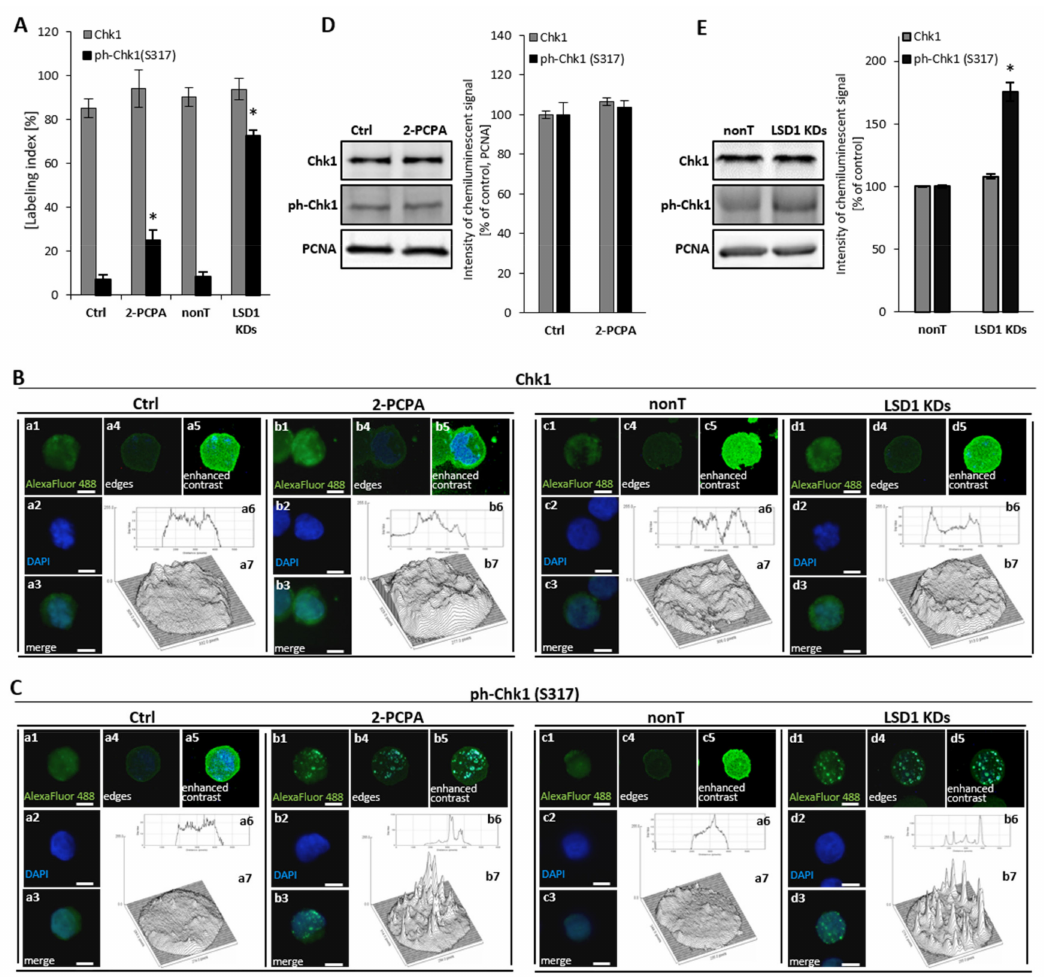
Figure 2. Consequences of LSD1 inhibition / silencing in human microvascular endothelial cells on checkpoint kinase 1 (Chk1) activation. Immunofluorescent analysis of the Chk1 level ( A , B ) and the Chk1 activation (ph-Chk1(S317) level ( A , C ). Cells were stained with anti-Chk1 or anti-ph-Chk1(S317) antibodies conjugated with AlexaFluor 488 fluorescent dye. The labeling index was calculated as the ratio of immunofluorescence-labeled cells to all cells in an HMEC-1 cell population. The intensity of fluorescence was visualized in ImageJ program ( B a6, a7, b6, b7; C a6, a7, b6, b7). The presented pictures are representative of three independent experiments. ( D ), ( E ) Analysis at the protein level of the expression of Chk1 and ph-Chk1 in ( D ) pharmacological and ( E ) transcriptional experimental models of LSD1 activity inhibition. Scale bars are equal to 10 µ m. Statistical significance was analyzed at * p < 0.05 using ANOVA and post hoc analysis by Tukey’s